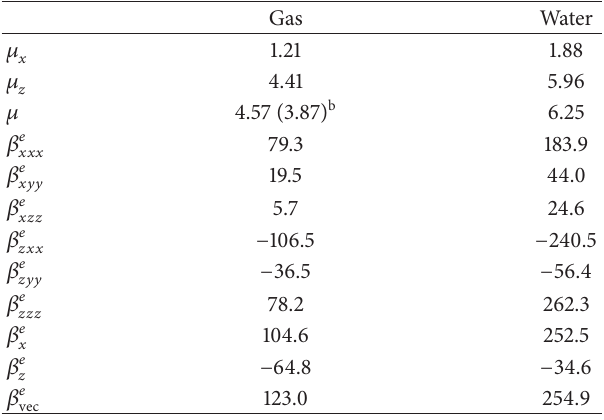
Table 1: Dipole moments 𝜇 (D) and static electronic first-order hyperpolarizabilities 𝛽 𝑒 (a.u.) of uracil a